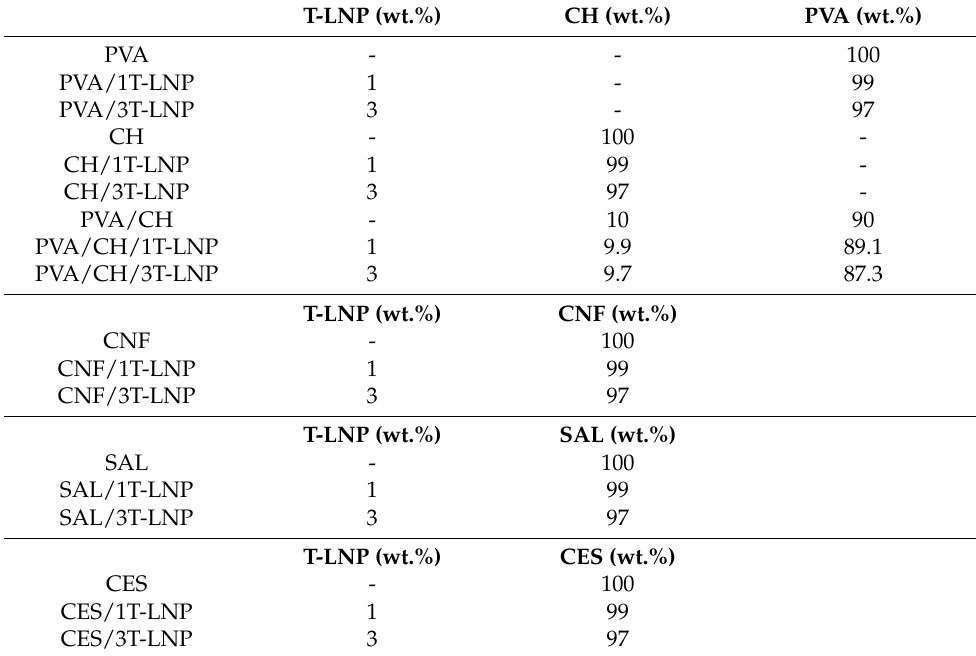
Table 1. LNP-based binary and ternary composite formulations. T-LNP